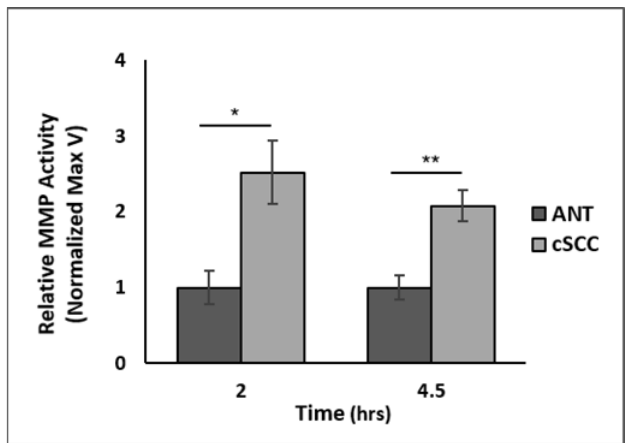
Figure 2. Fluorescence resonance energy transfer (FRET) assay of MMP activity in tissue samples. Cell lysates from homogenized ANT and cSCC tissues were used to assess relative MMP activity, measured at two different time points after MMP activation. All values are expressed as mean ± SEM. * denotes p < 0.05 and ** denotes p < 0.01.